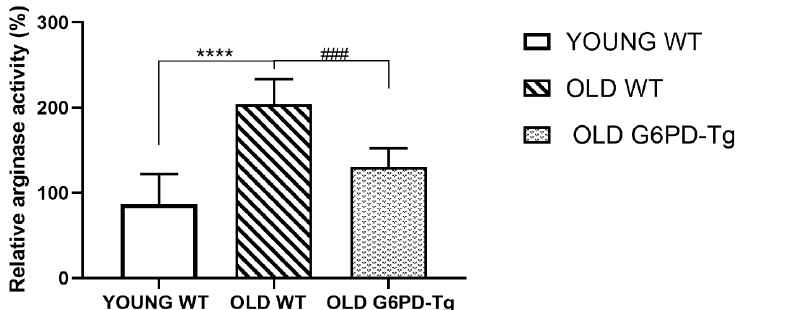
Figure 4. Relative arginase activity in the aortic rings. Results are means ± SD ( n = 5–8 per group). **** p < 0.0001 between WT groups; ### p < 0.001 between old groups.